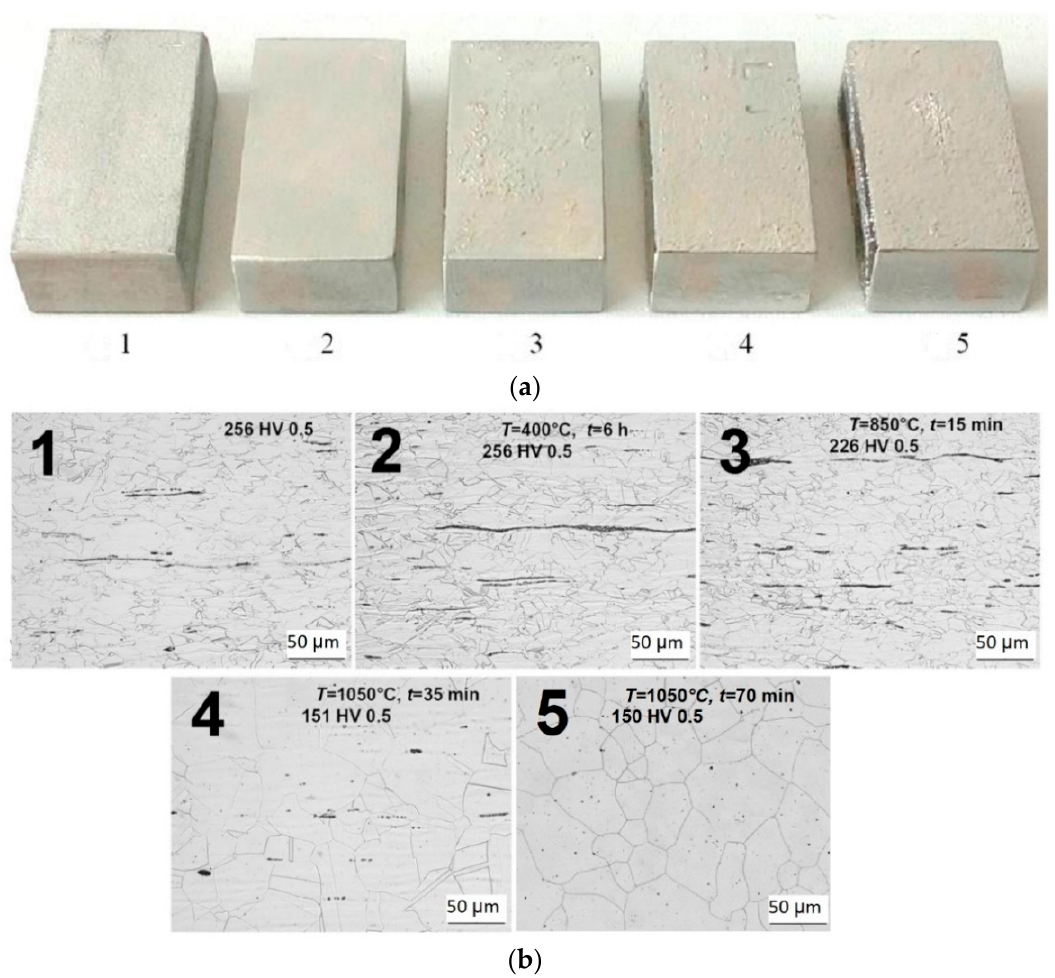
Figure 4. Investigated specimens of biomaterial AISI 316L. ( a ) Material specimens ( b ). A microstruc- ture of specimens.